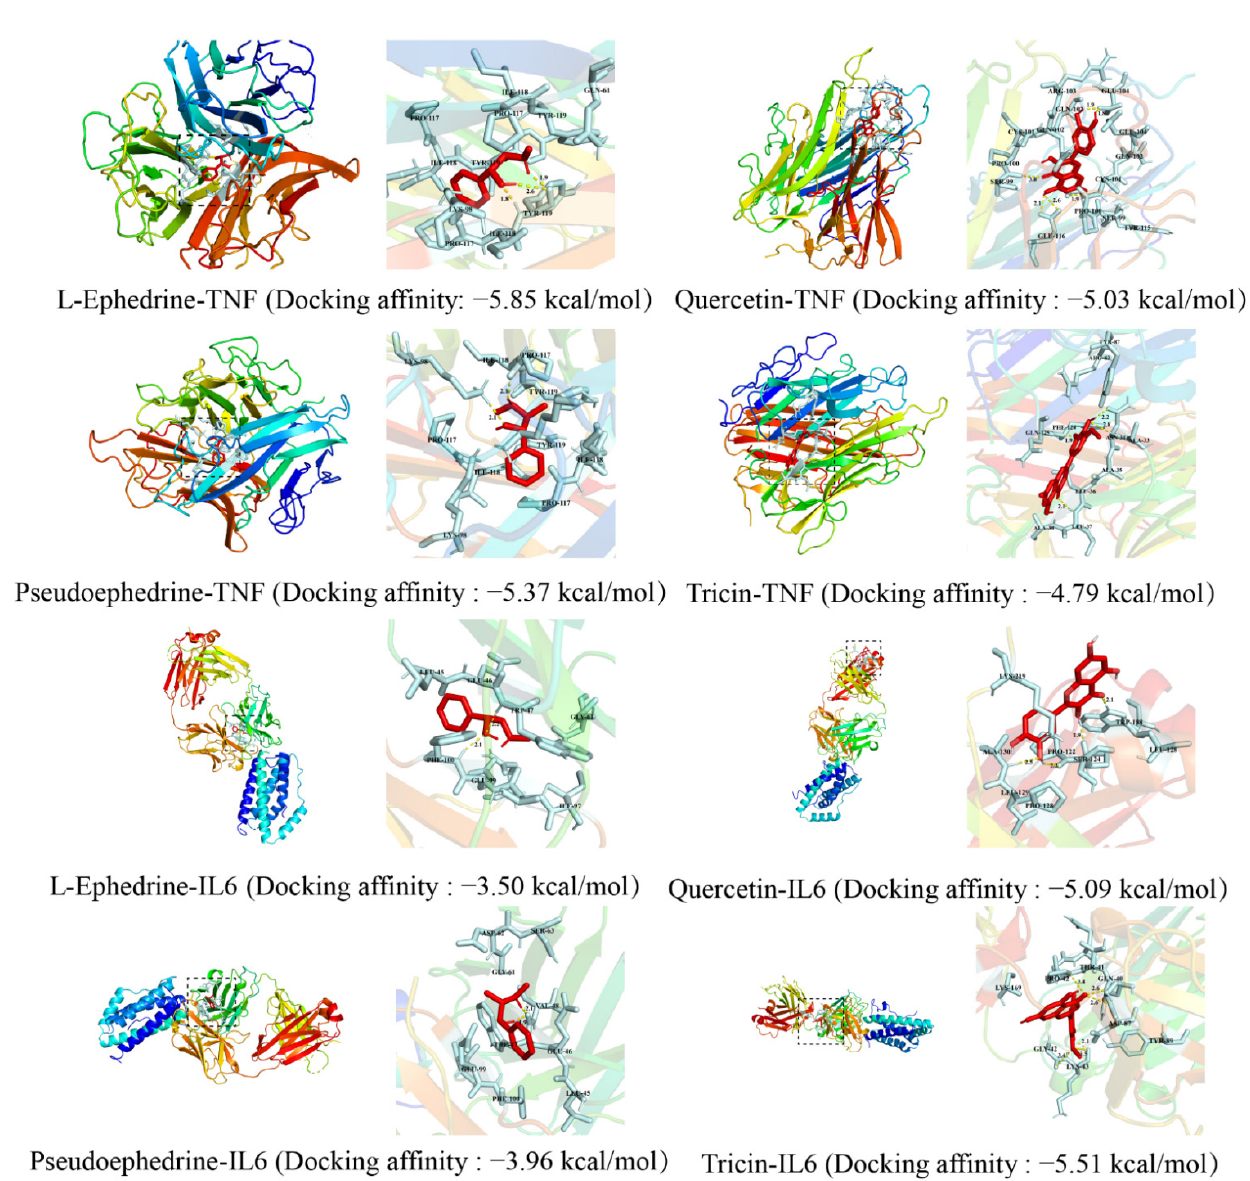
Figure 5. Molecular docking of active ingredients and bub targets.